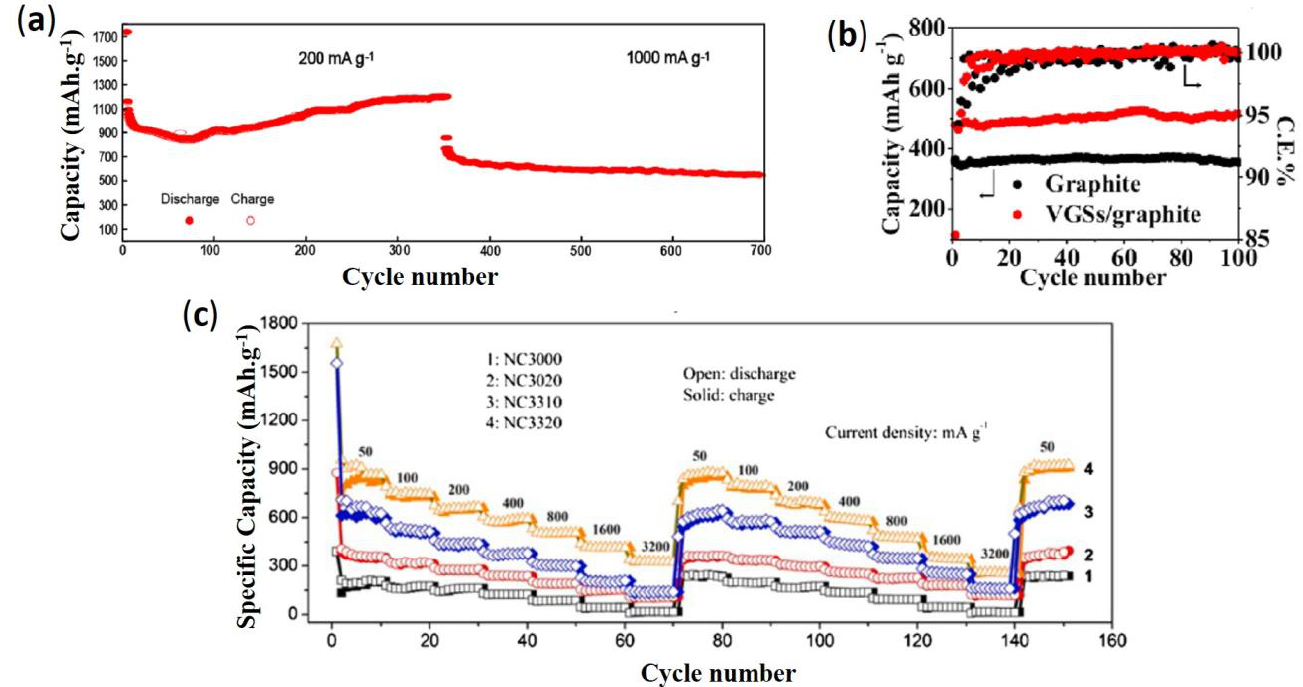
Figure 3. ( a ) Long-term cycling performance of CoCl 2 -FeCl 3 -GICs at 200 and 1000 mA · g − 1 [66]. ( b ) Cycling curves of graphite and vertical graphene sheets (VGSs)/graphite at 0.2 C [67]. ( c ) Rate performance at various current densities for the different nitrogen-doped graphene-like carbon nanosheets samples [68].